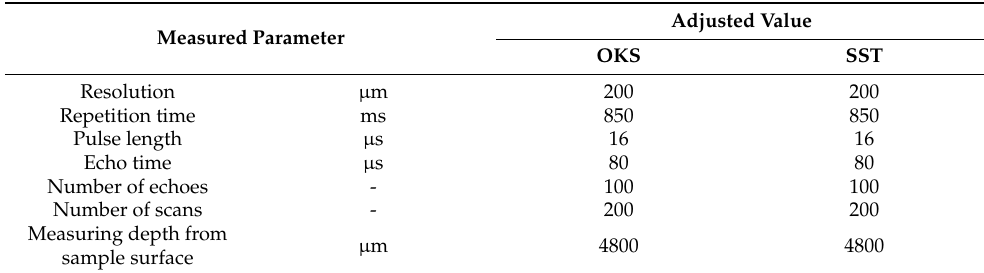
Table 3. Measurement parameters and adjusted